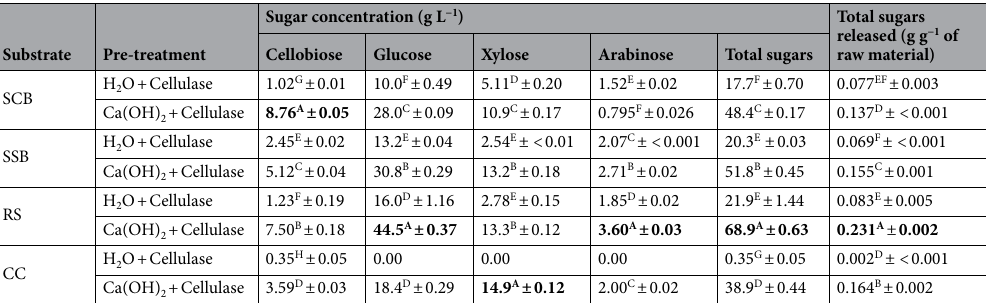
Table 1. Sugar content of raw materials after chemical and enzymatic pretreatment. Numbers with the same uppercase alphabet indicated no significant difference (p > 0.05) for comparison of the same column. Bold data indicated the best average value(s) within each column. SCB, sugarcane bagasse; SSB, sweet sorghum bagasse; RS, rice straw; CC, corncob.